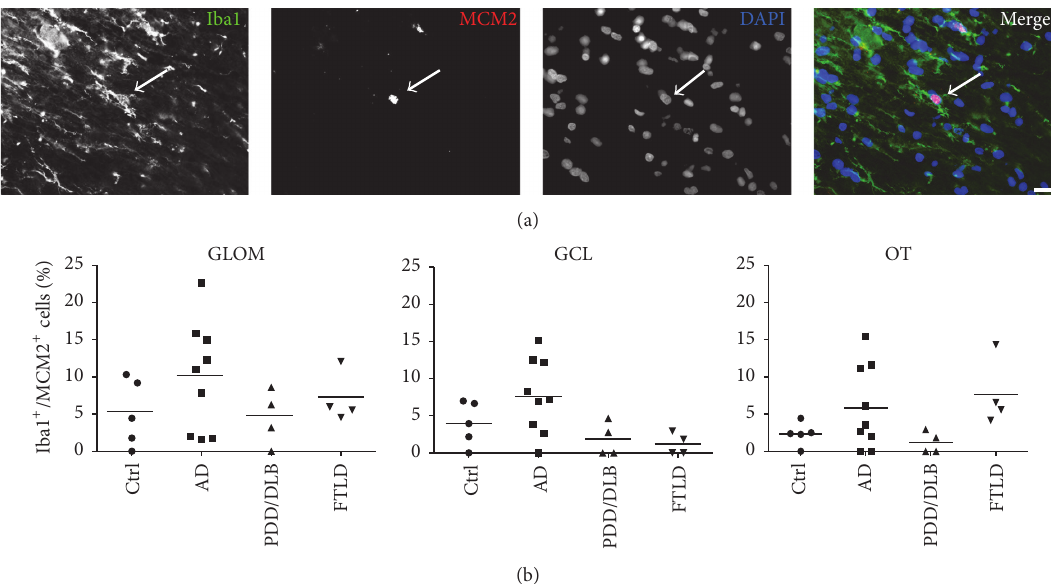
Figure 7: A small proportion of Iba1+ microglia was expressing MCM2, however without differences between controls and AD, PDD/DLB, or FTLD in the GLOM, GCL, and OT. (a) Triple-immunostaining showing a representative proliferating microglia cell expressing MCM2 and Iba1, DAPI as nuclear stain. (b) Percentage of Iba1+ microglia coexpressing the proliferation marker MCM2 in the three regions of the OB of controls and AD, PDD/DLB, and FTLD cases remains unaltered. 1-way ANOVA, 𝑝 > 0.05 for all groups. Scale bar represents 20 𝜇